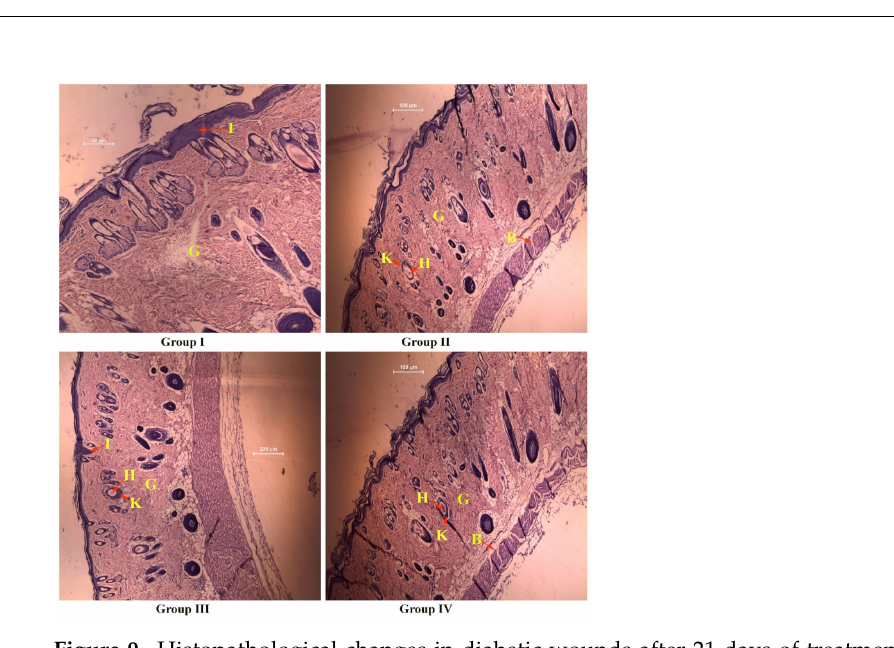
Figure 9. Histopathological changes in diabetic wounds after 21 days of treatments (animals of groups I, II, III, and